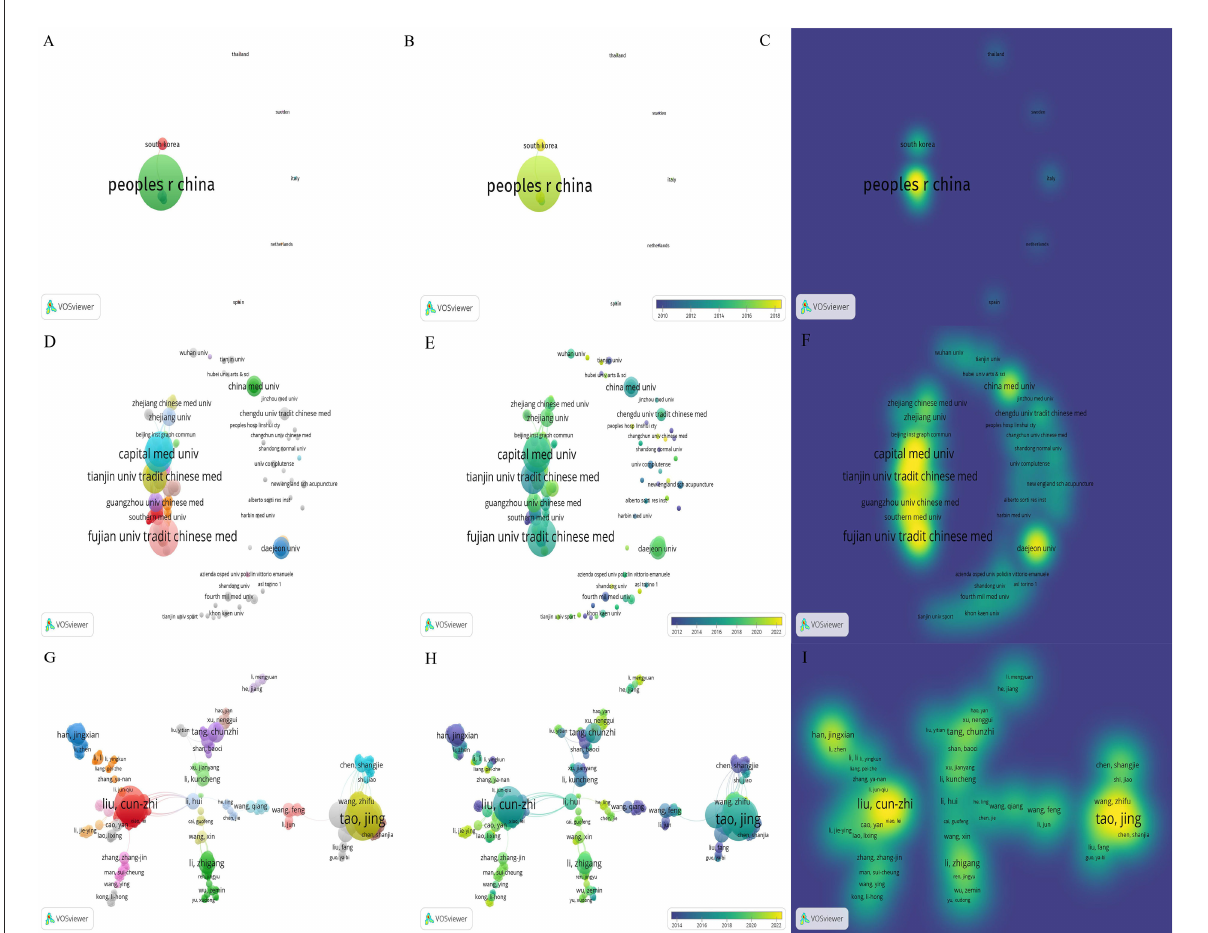
FIGURE5 The network map of countries/regions, institutes, and active authors. (A) The Network Visualization map of countries/regions, (B) the Overlay Visualization map of countries/regions, and (C) the Density Visualization map of countries/regions. (D) The Network Visualization map of institutes, (E) the Overlay Visualization map of institutes, and (F) the Density Visualization map of institutes. (G) The Network Visualization map of active authors, (H) the Overlay Visualization map of active authors, and (I) the Density Visualization map of active authors.